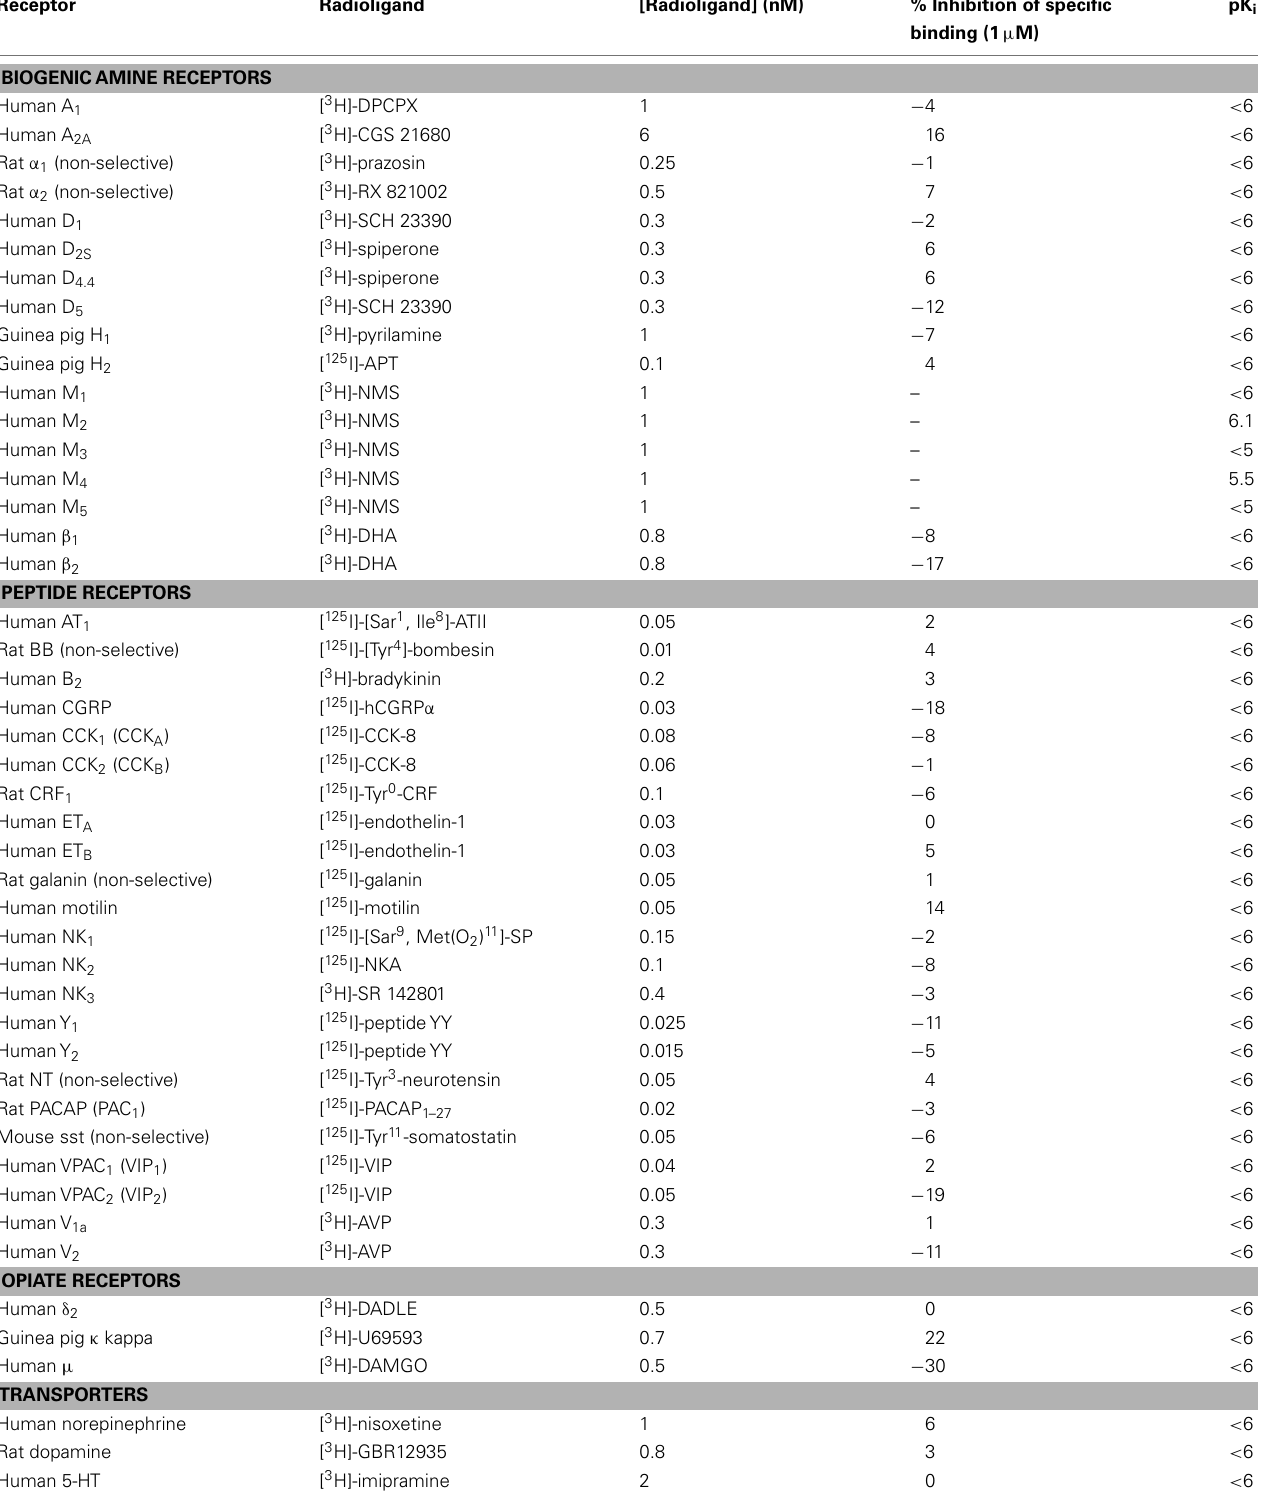
Table 3 | Binding data (% inhibition of specific binding and pK i values) ofTD-8954 at non-5-HT receptors, transporters, ion channels, and